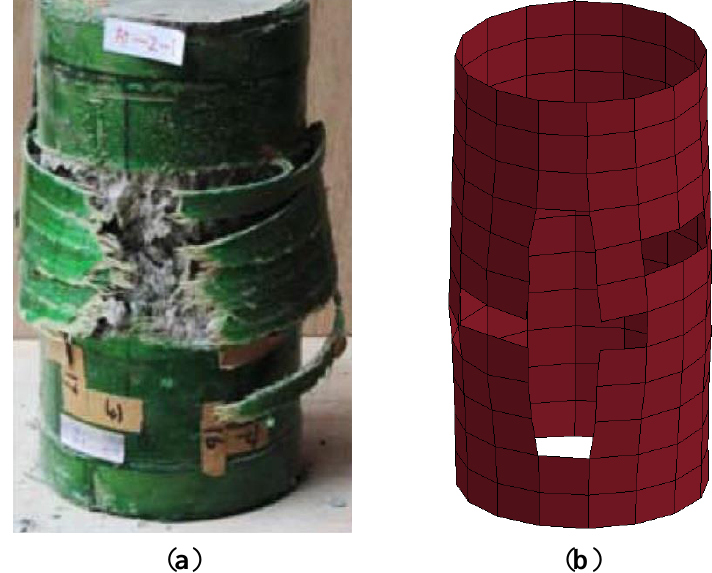
Figure 3. FRP rupture in FE analysis and experimental work by Dai et al. [13] (reprinted with permission from [13]. Copyright 2011 ASCE) of the PEN-600-I: ( a ) Experimental and ( b )